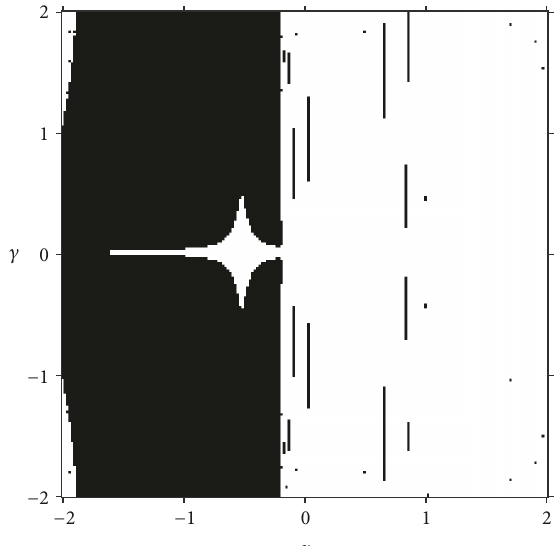
Figure 3: Unified parameter plane of 𝑥 𝐶 5−10 .